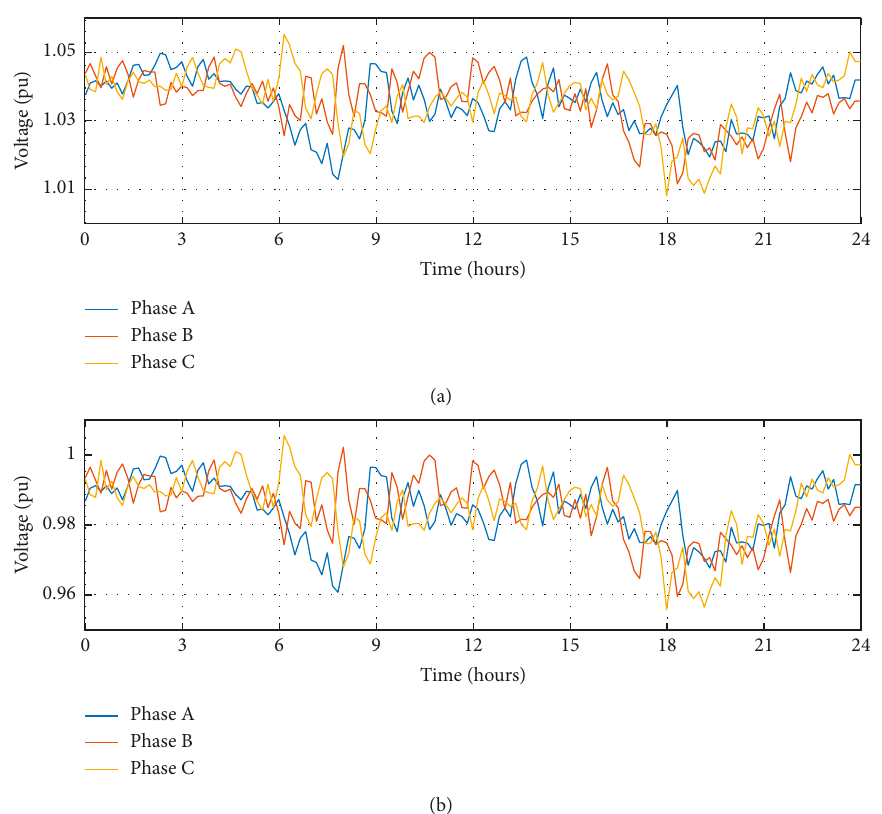
Figure 8: Three-phase voltage at Bus 9 before PV power integration with different upstream voltages: (a) highest upstream voltage (1.05pu); (b) lowest upstream voltage